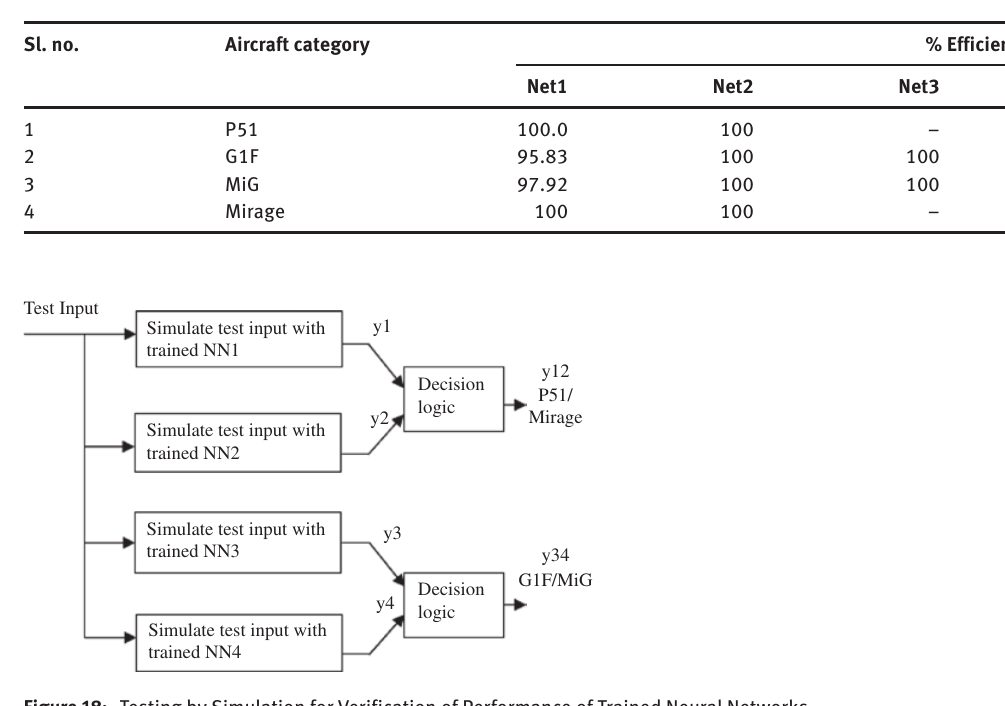
Figure 18: Testing by Simulation for Verification of Performance of Trained Neural Networks.